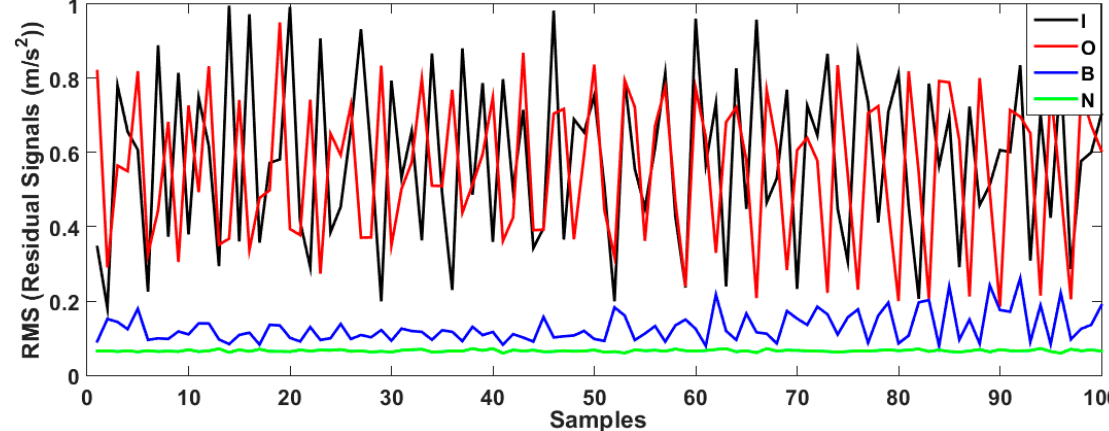
Figure 9. Bearing’s RMS residual signals using the VS technique.